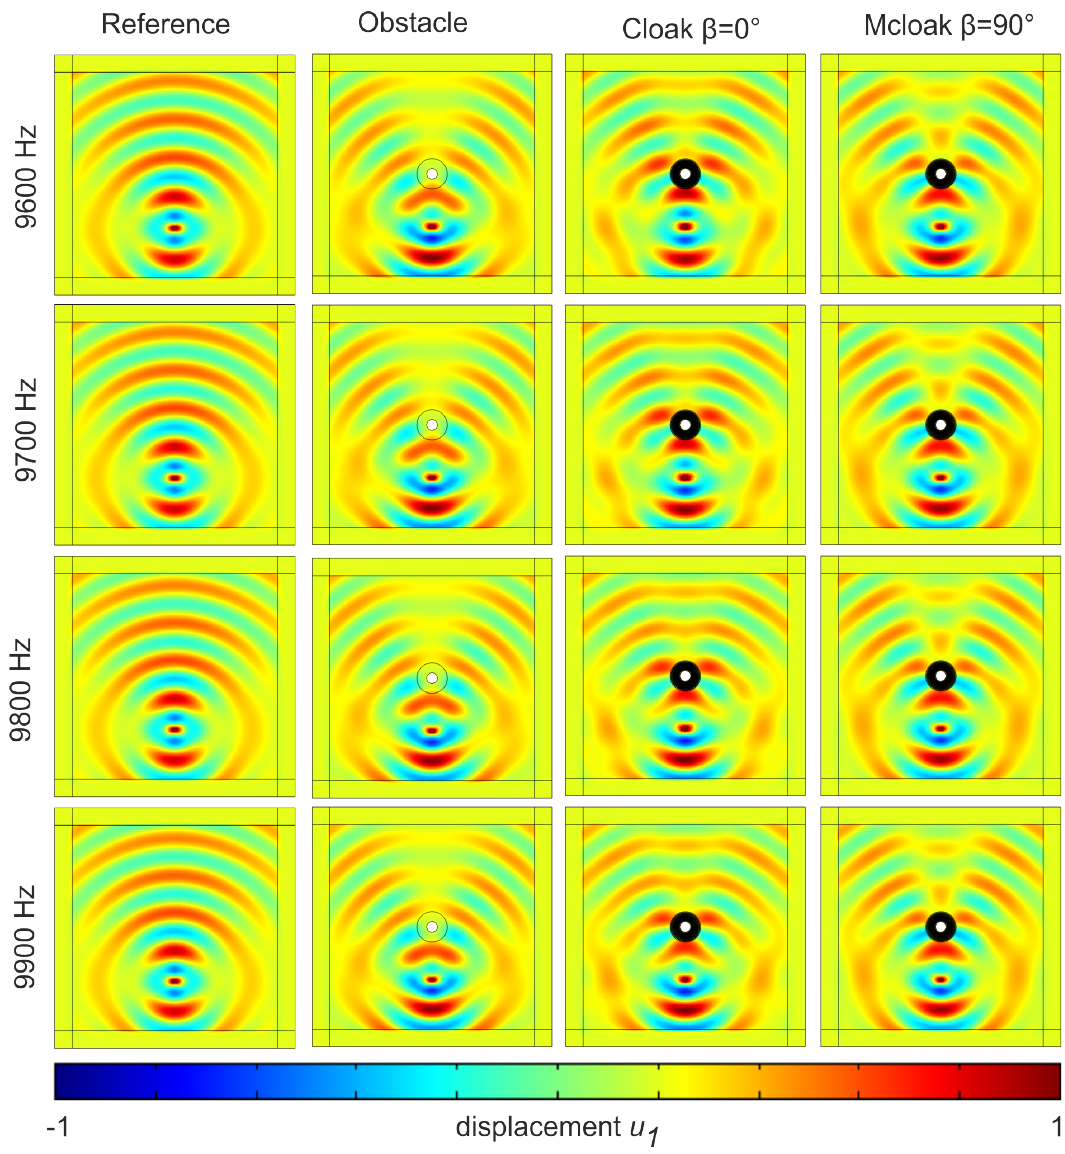
Figure 2. In-plane shear elastic wave generated by a point force located at ( x 1 , x 2 ) = ( 0, − 150 ) and oriented along the x -axis. This S wave propagates within an isotropic homogeneous elastic bulk (here PMMA) with a cloak centered at (0,0) of inner radius r 1 = 1.5 cm and outer radius r 2 = 4 cm and consisting of 11 concentric layers of Swiss rolls made of a soft material ( λ = 6.10 5 Pa and µ = 4.10 4 Pa). The wave frequency ranges from 9.6 to 9.9 kHz. Please note that Cartesian elastic Perfectly Matched Layers have been set on either sides of the square computational domain. First column is for the shear polarized point source in PMMA (benchmark); Second column has a clamped obstacle centered at (0,0) of radius r 0 = 3 cm; Third column is for the source with clamped obstacle and cloak. Fourth column is same when the Swiss rolls have been tilted through an angle β = π /2 about their gravity center, which is a modified cloak (Mcloak). Scattering of clamped obstacle is reduced for cloak, unlike for